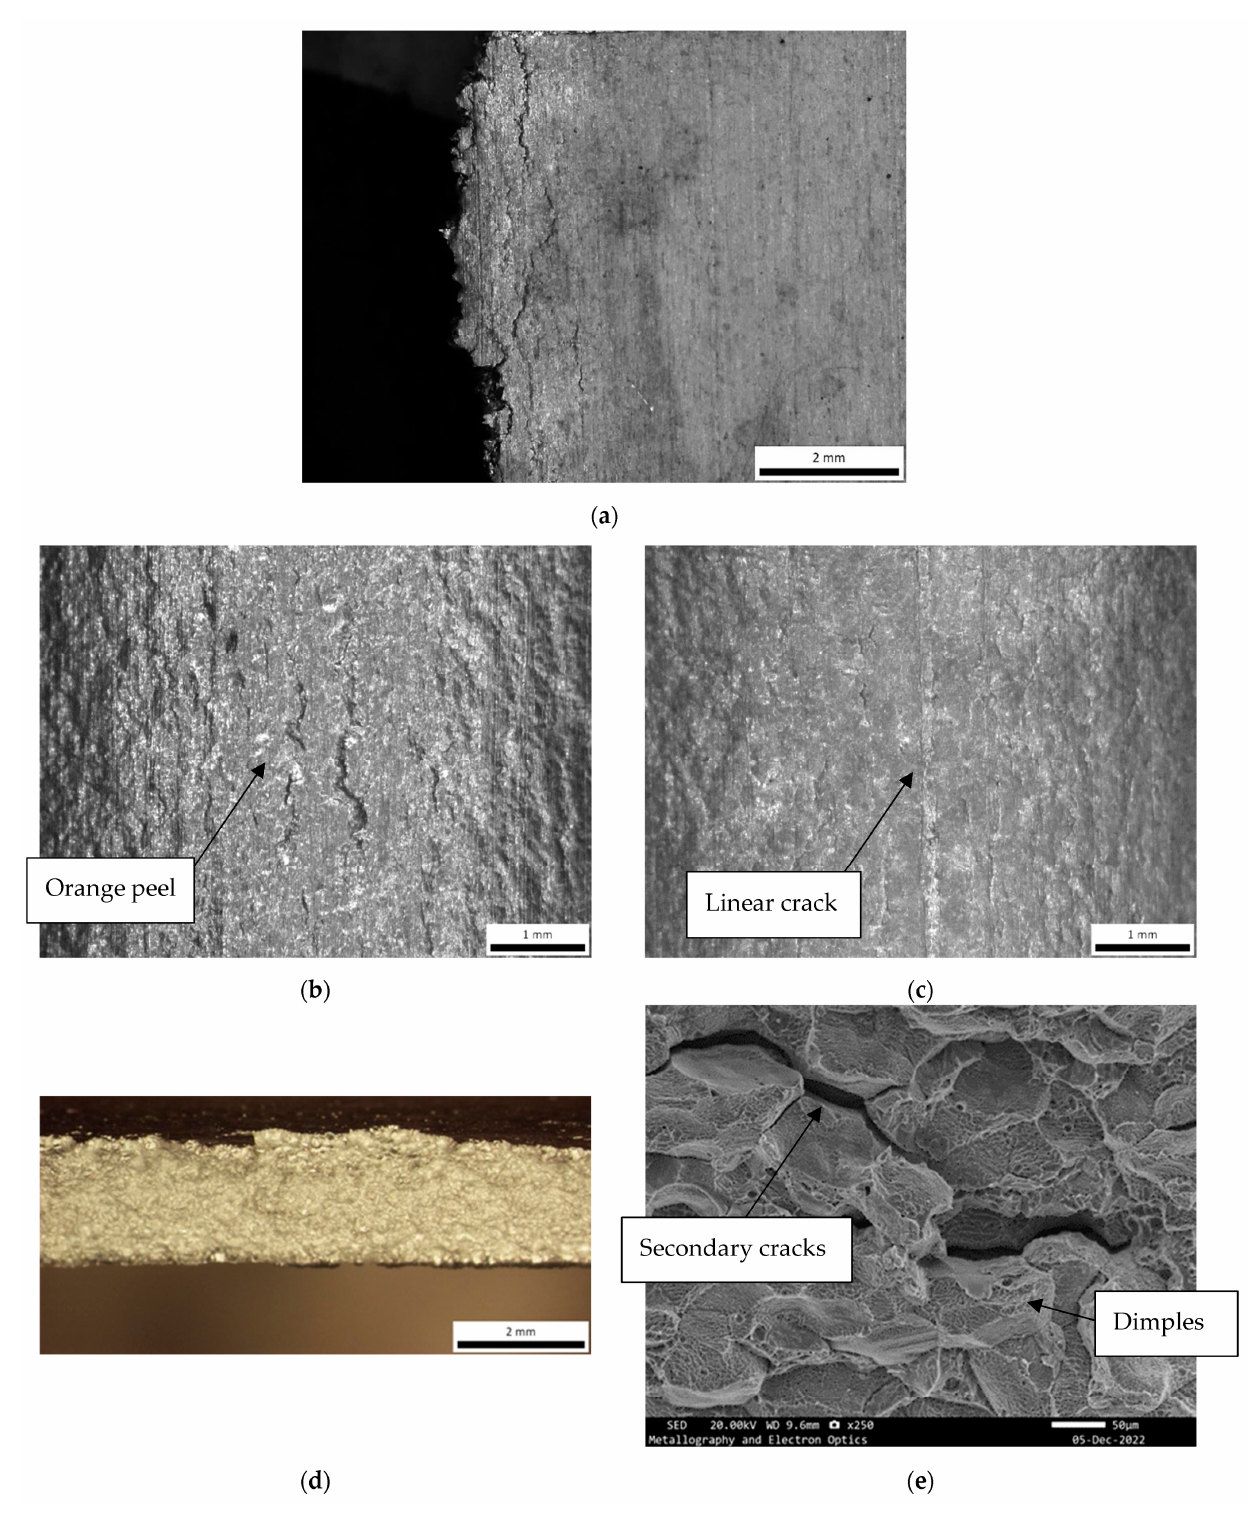
Figure 1. ( a ) AC sample divided into two pieces during a three-point bending test from the top-view imaging of the fracture area; ( b ) “orange peel” on the bent region of the WQ ample after a three-point bending test; ( c ) linear minor crack coinciding with the bending line on the bent region of the SC sample; ( d ) fracture surface of the sample AC after a three-point bending test. The intergranular fracture mode was noticed; ( e ) electron fractograph of the same area. The intergranular fracture mode accompanied by fine, shallow dimples on the grain faces and brittle intergranular secondary cracks was noted.